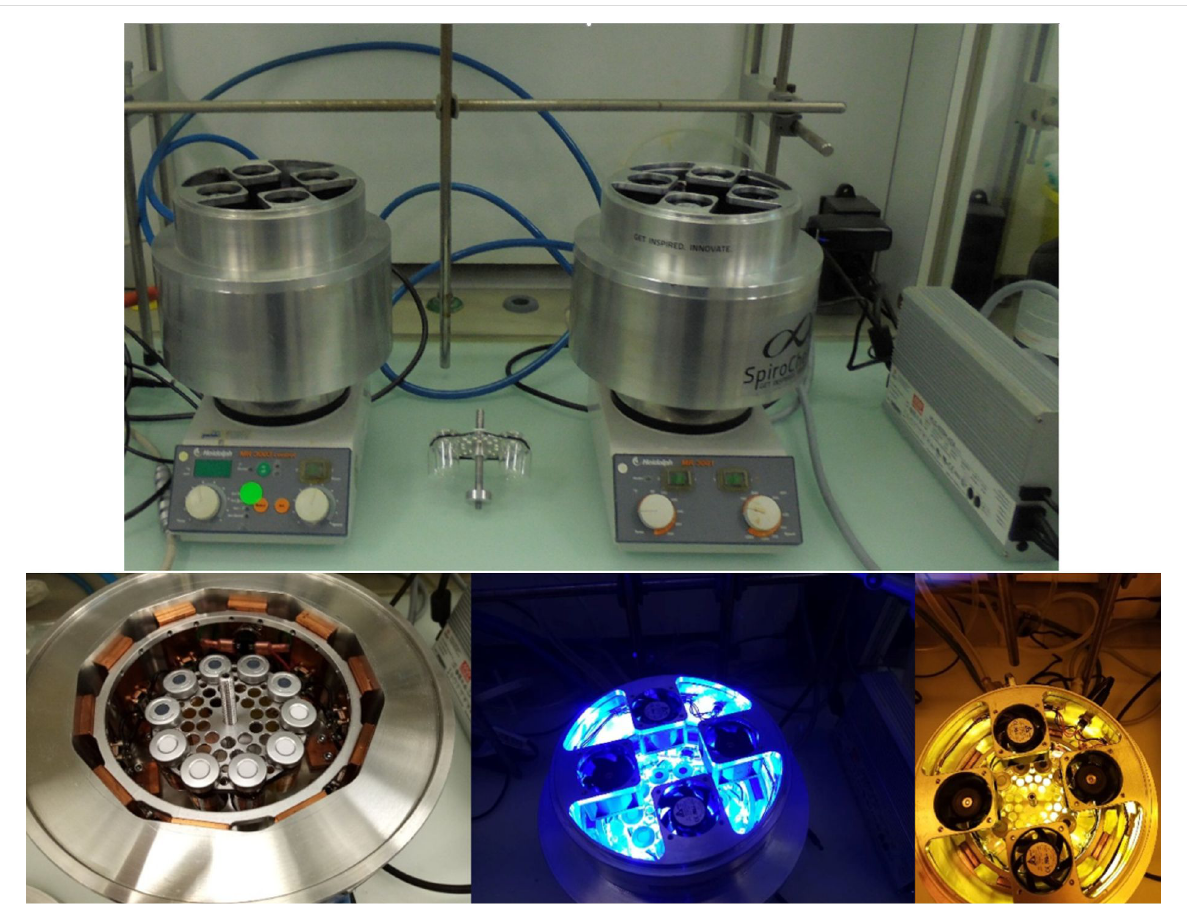
Figure 1: Top: high-power blue LED photoreactors. Bottom, from left to right: photoreactor OFF, ON, and ON through protective yellow filter.